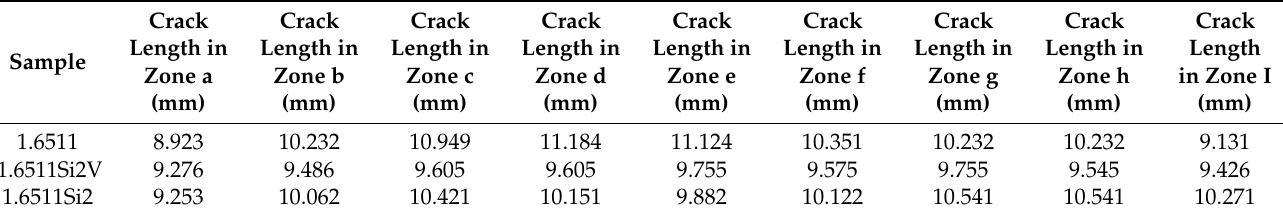
Figure 16. Cross section of the CTOD sample fracture surfaces and length of the crack (a to i) for ( a ) 1.6511, ( b ) 16511Si2V, and ( c ) 1.6511Si2. Note: In CFB samples, the crack lengths are more uniform compared with the no CFB sample. Table 3 . Crack length of the sample after failure in the CTOD test .